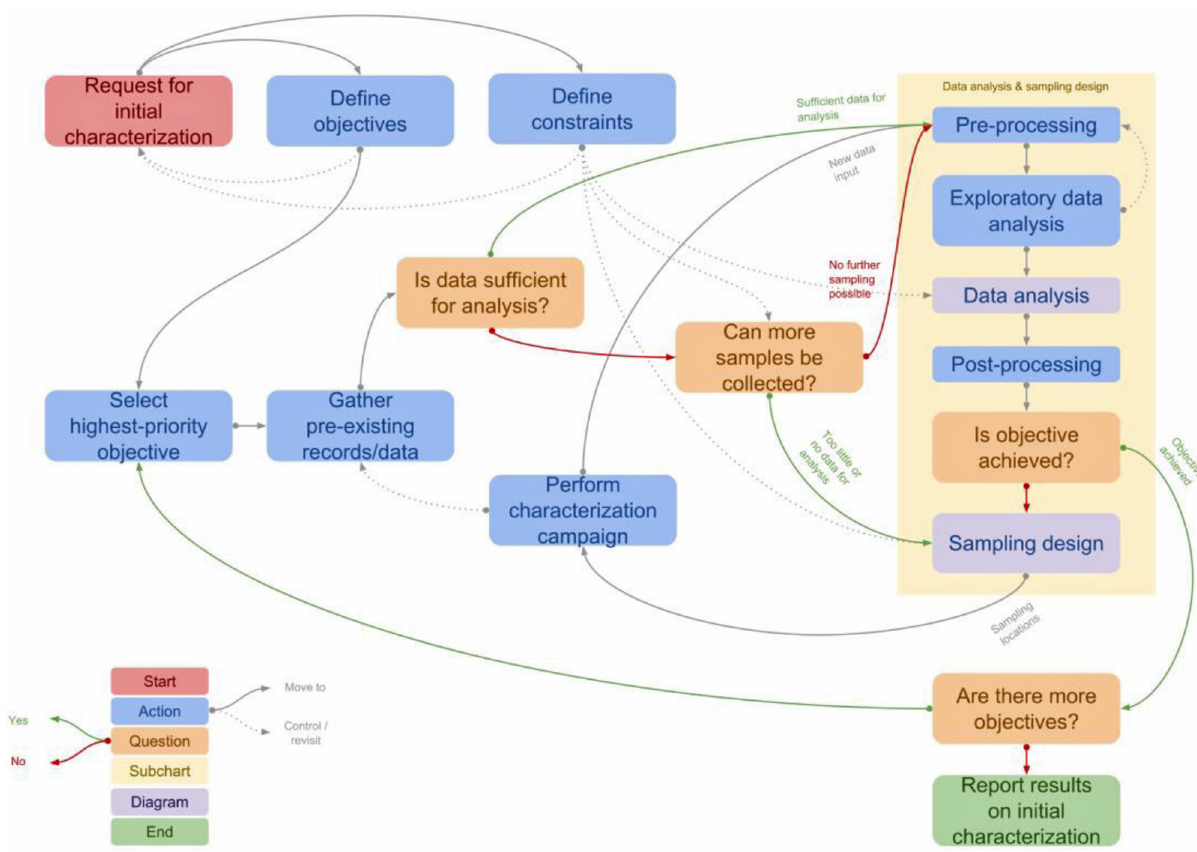
Fig. 2. Overall fl owchart for sampling strategy and data